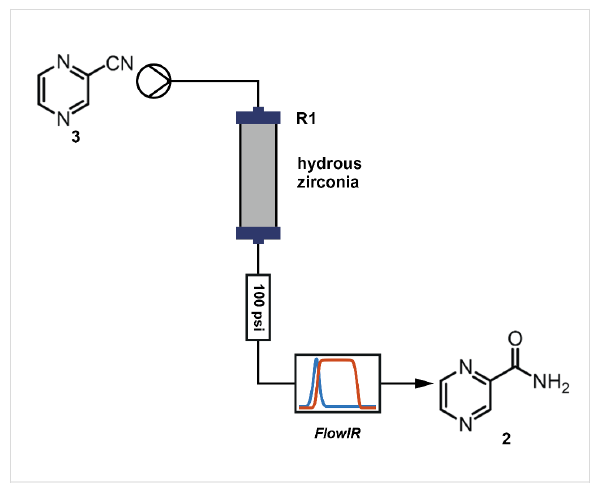
Figure 3: Heterogeneous hydration of pyrazine-2-carbonitrile with hydrous zirconia.